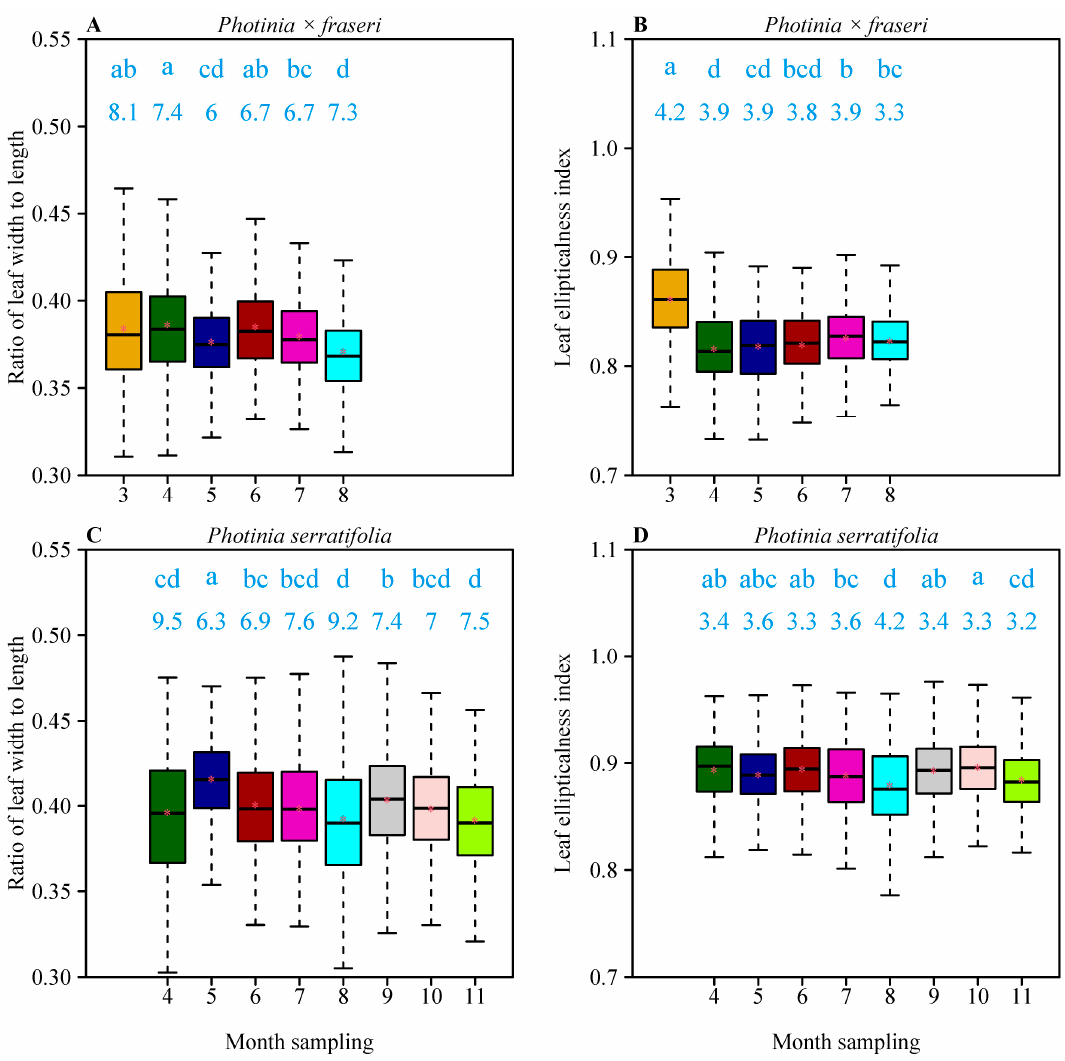
Figure 4. Comparison of leaf shapes (reflected by the ratio of leaf width to length and leaf ellipticalness index) across different sampling months for P. × fraseri ( A , B ) and P. serratifolia ( C , D ). In each panel, the letters on the whiskers represent the significance of the differences in leaf shape between any two sampling months among which the letters a, b, c, and d are used to represent the significance of differences in leaf shape among different sampling months; groups sharing a common letter are not significantly different at the 0.05 significance level; the values at the top of whiskers represent the coefficients of variation (%) for each sampling month; the horizontal solid line represents the median; the red asterisk represents the mean. The whiskers extend to the most extreme data point, which is no more than 1.5 times the interquartile range from the box. For the label of the x -axis, the months 3 to 11 represent March to November 2021, respectively. The differences in the means of leaf-shape indices, HSD values, and the corresponding 95% Tukey’s test confidence intervals between any two groups for P. × fraseri and P. serratifolia are provided in Tables S3 and S4, respectively. Table 1. Regression statistics of the leaf-shape index vs. sampling month.